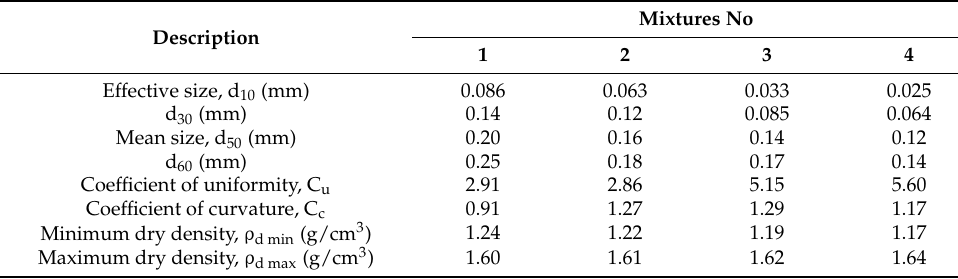
Table 3. Specifications of RCA mixtures.